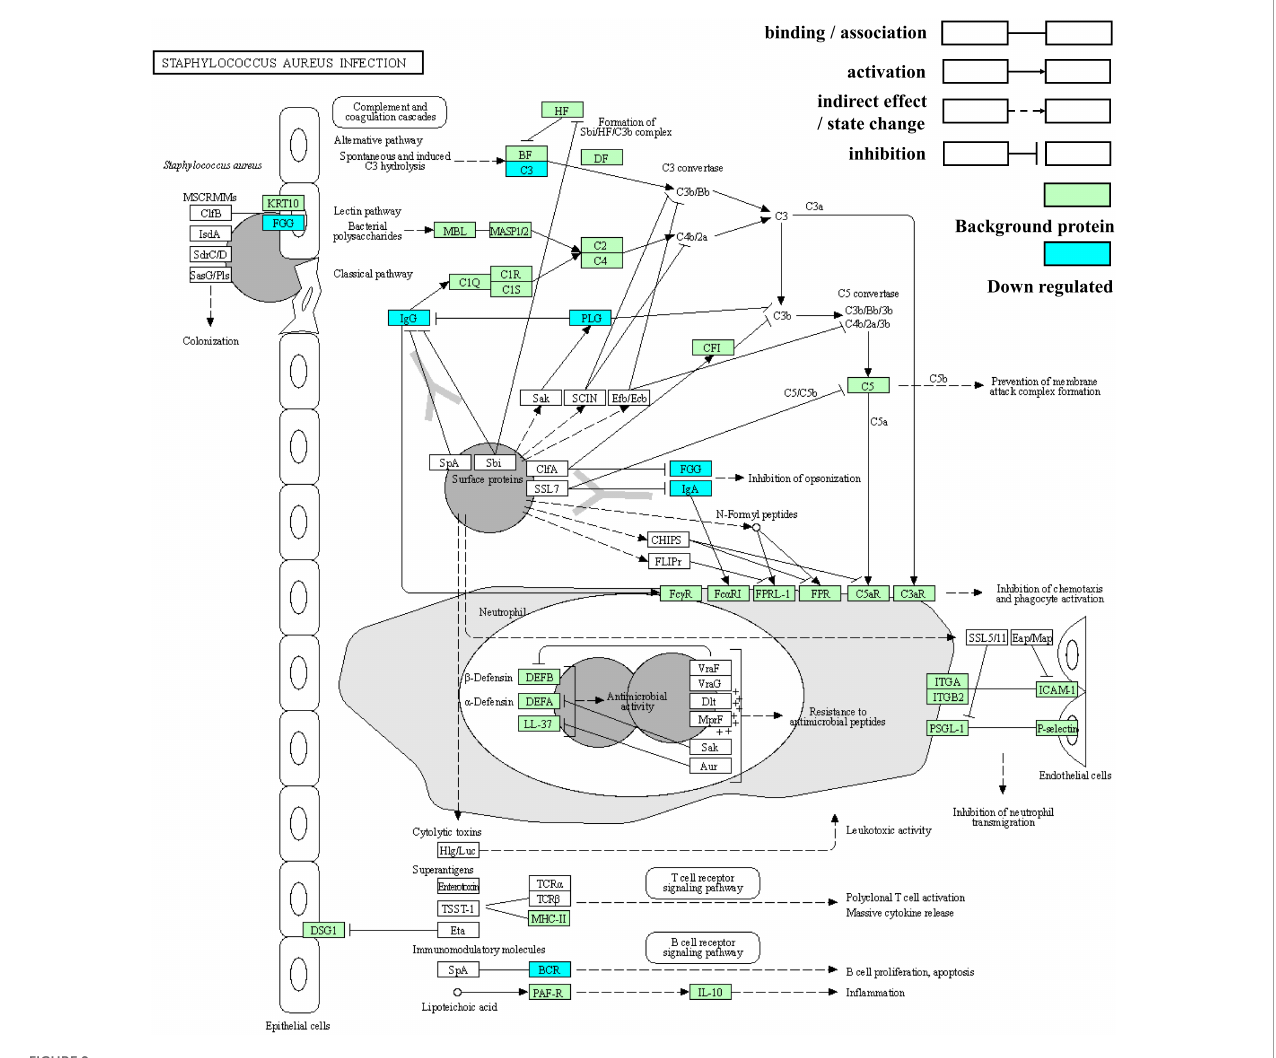
FIGURE9 Kyoto Encyclopedia of Genes and Genomes enrichment pathway map of Staphylococcus aureus infection.